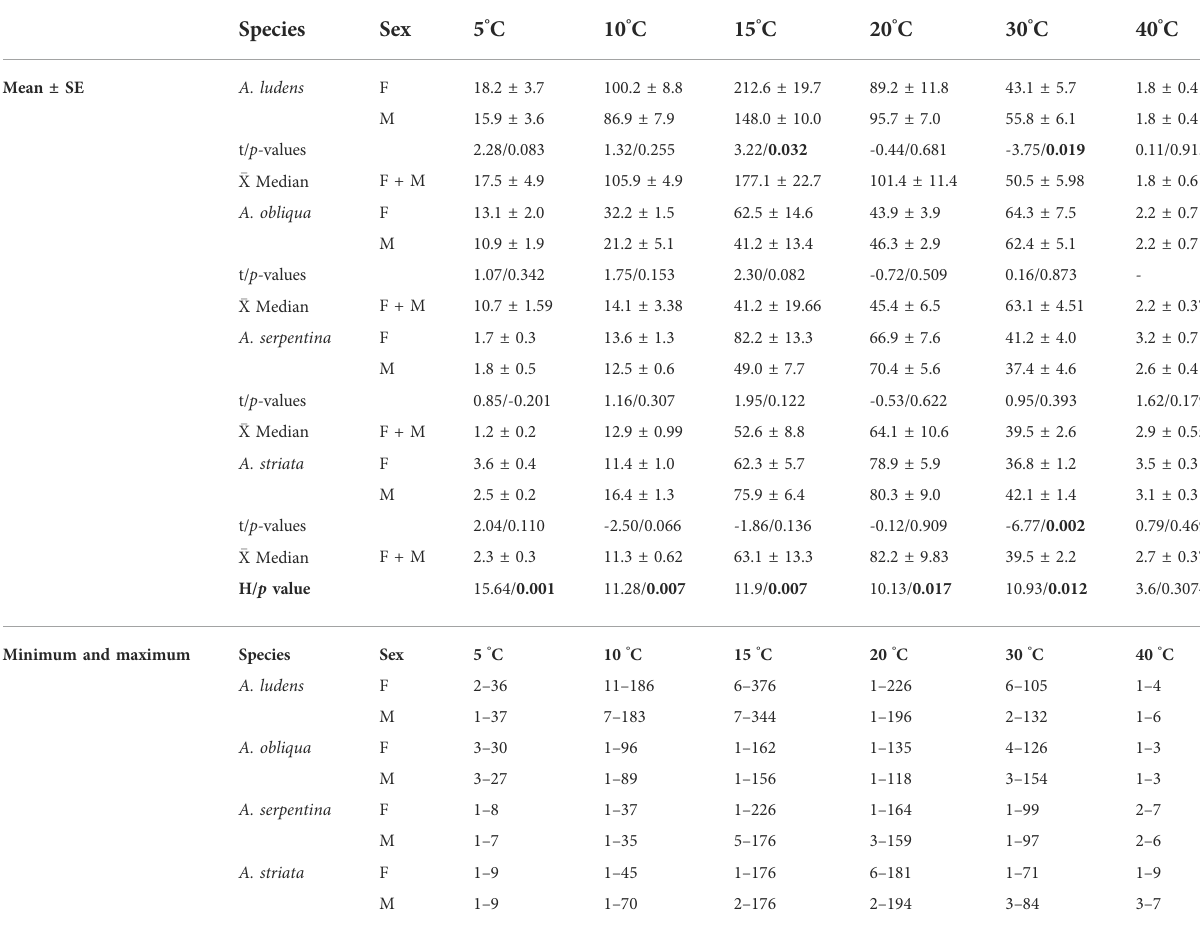
TABLE 1 Female and male survivorship (mean ± SE, minimum and maximum values of days) of four Anastrepha species exposed to different temperatures in bioclimatic chambers. Results of the t -Test for Dependent Samples analysis to compare female and male survivorship of each species (t and p- values), mean ± SE of median survivorship of each species (females and males together) and Kruskal – Wallis test results (H and p -value) to compare mean of medians by temperature. p -values in bold denotes statistically clear